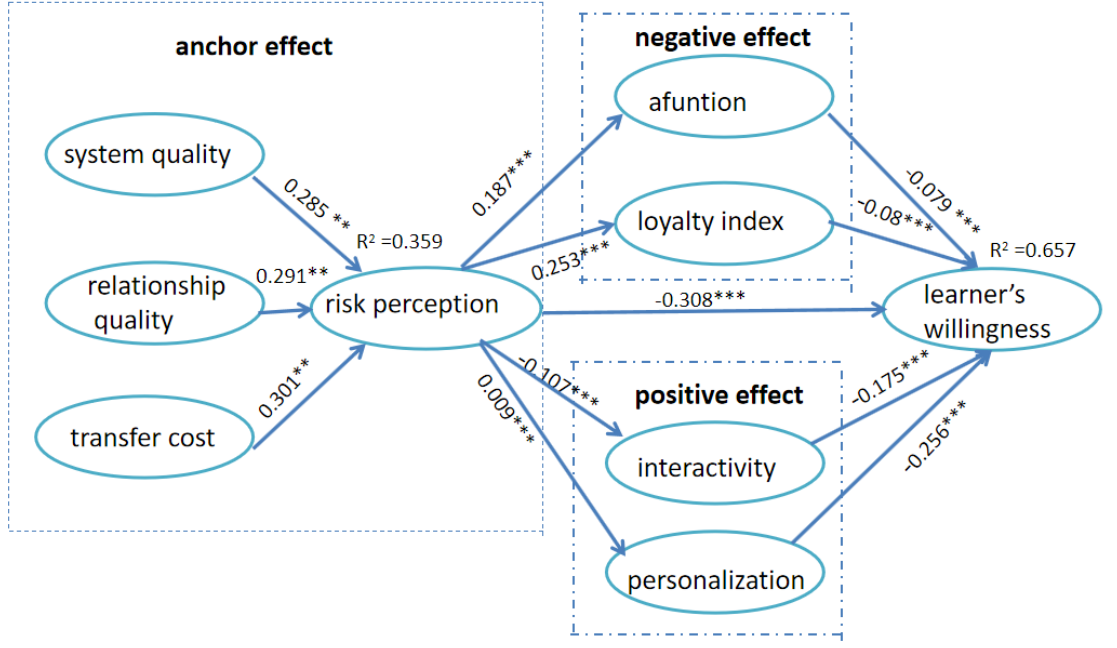
Figure 2. Coe ffi cients of pathway for structural models. Note: about the p value: * p < 0.05; ** p < 0.01; Figure 2. Coefficients of pathway for structural models. Note: about the p value: * p <0.05; ** p *** p < <0.01;*** p <0.001.